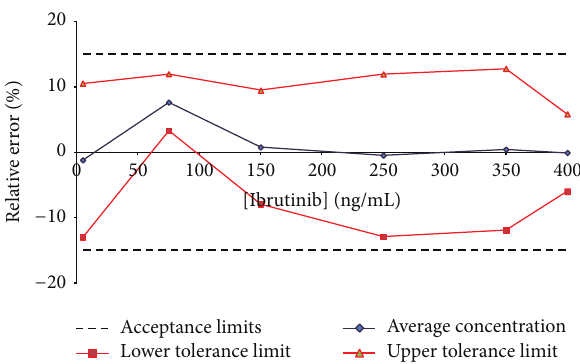
Figure 5: Accuracy profile for ibrutinib in human plasma; 𝛽 expectation tolerance interval set at 95% and 𝜆 acceptance limits set at ± 15%. All tested concentrations were validated (from 5 to 400